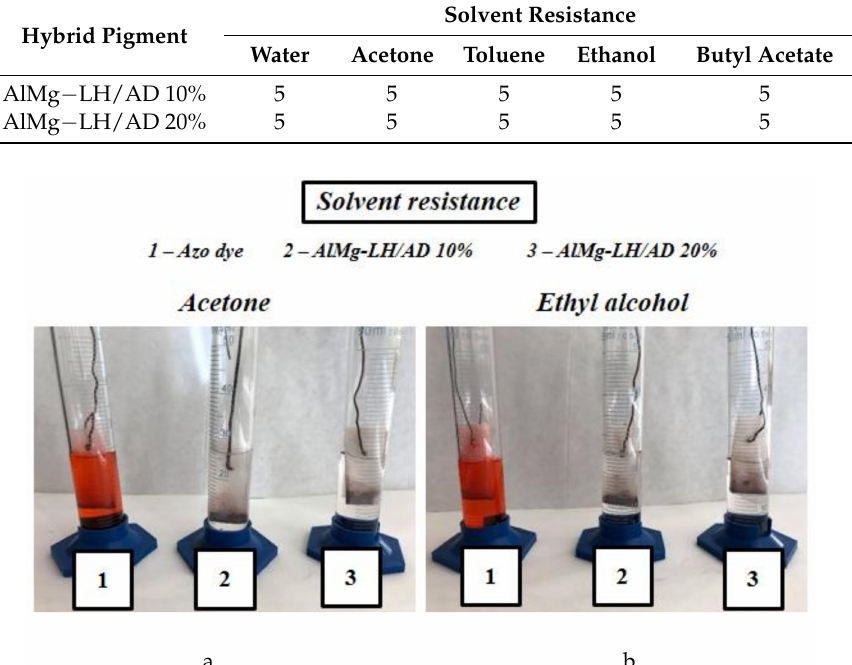
Table 1. Solvent resistance of hybrid pigments.